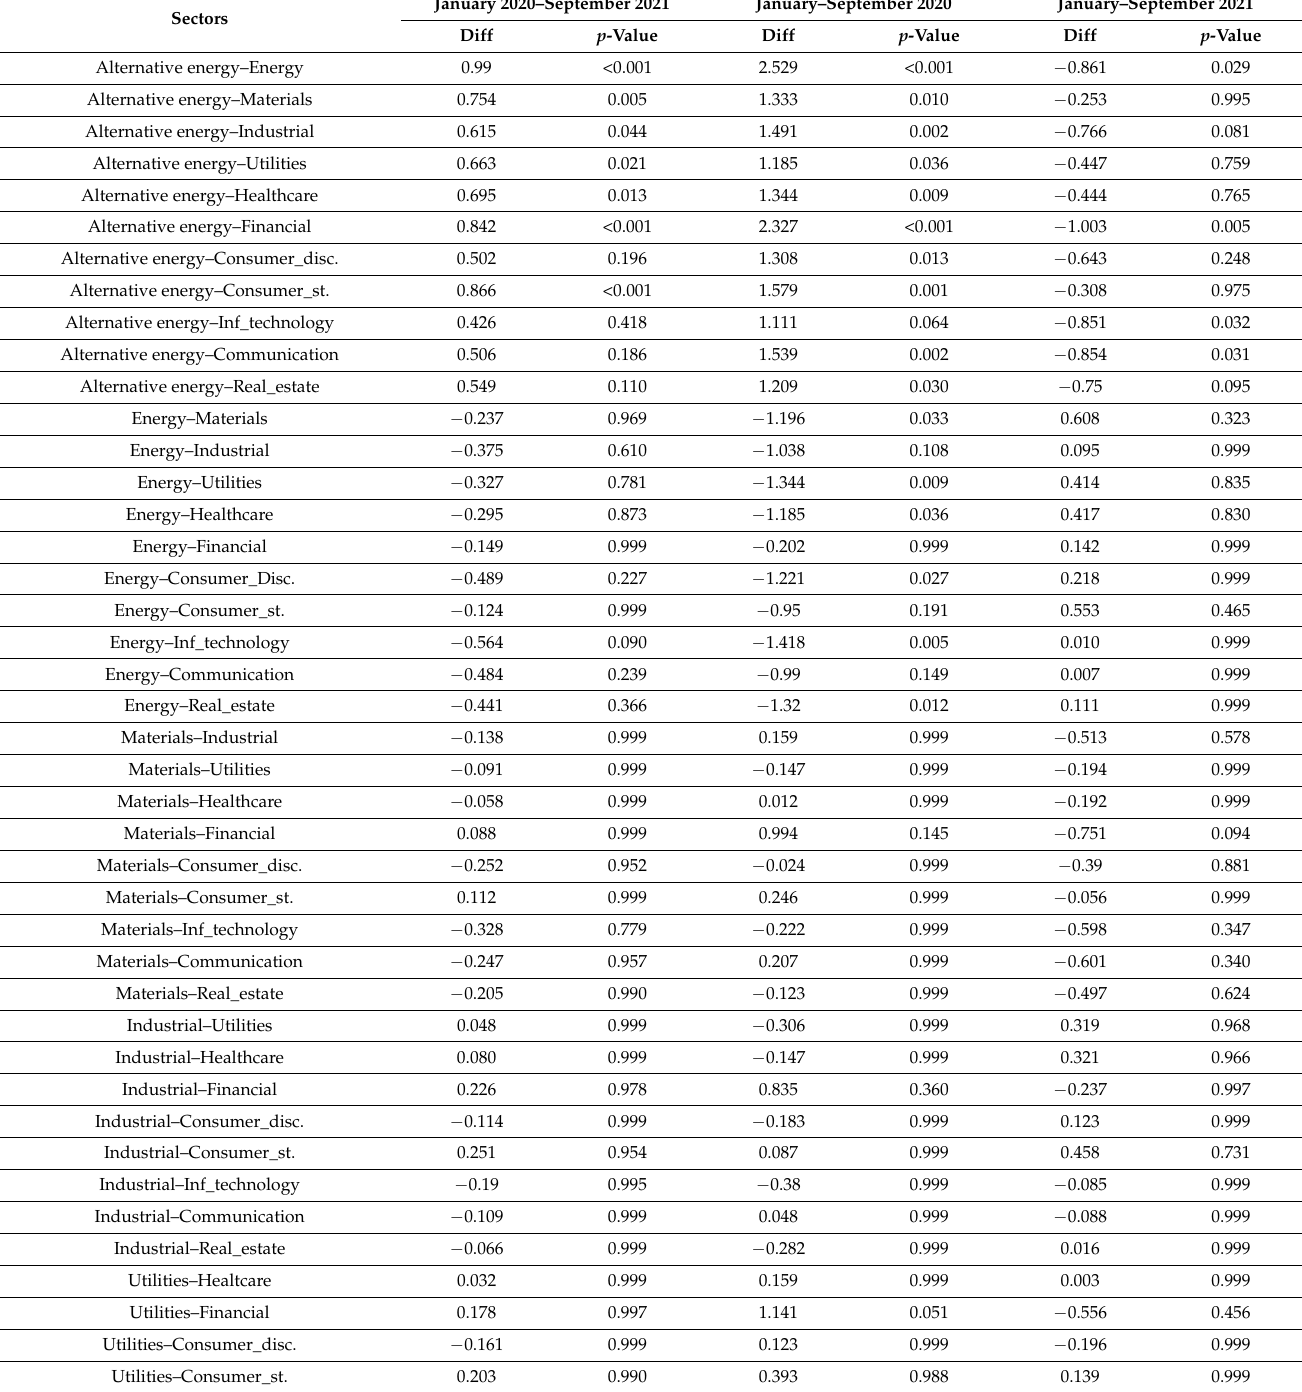
Table 6. Tukey’s honest significance test results (Tukey’s HSD